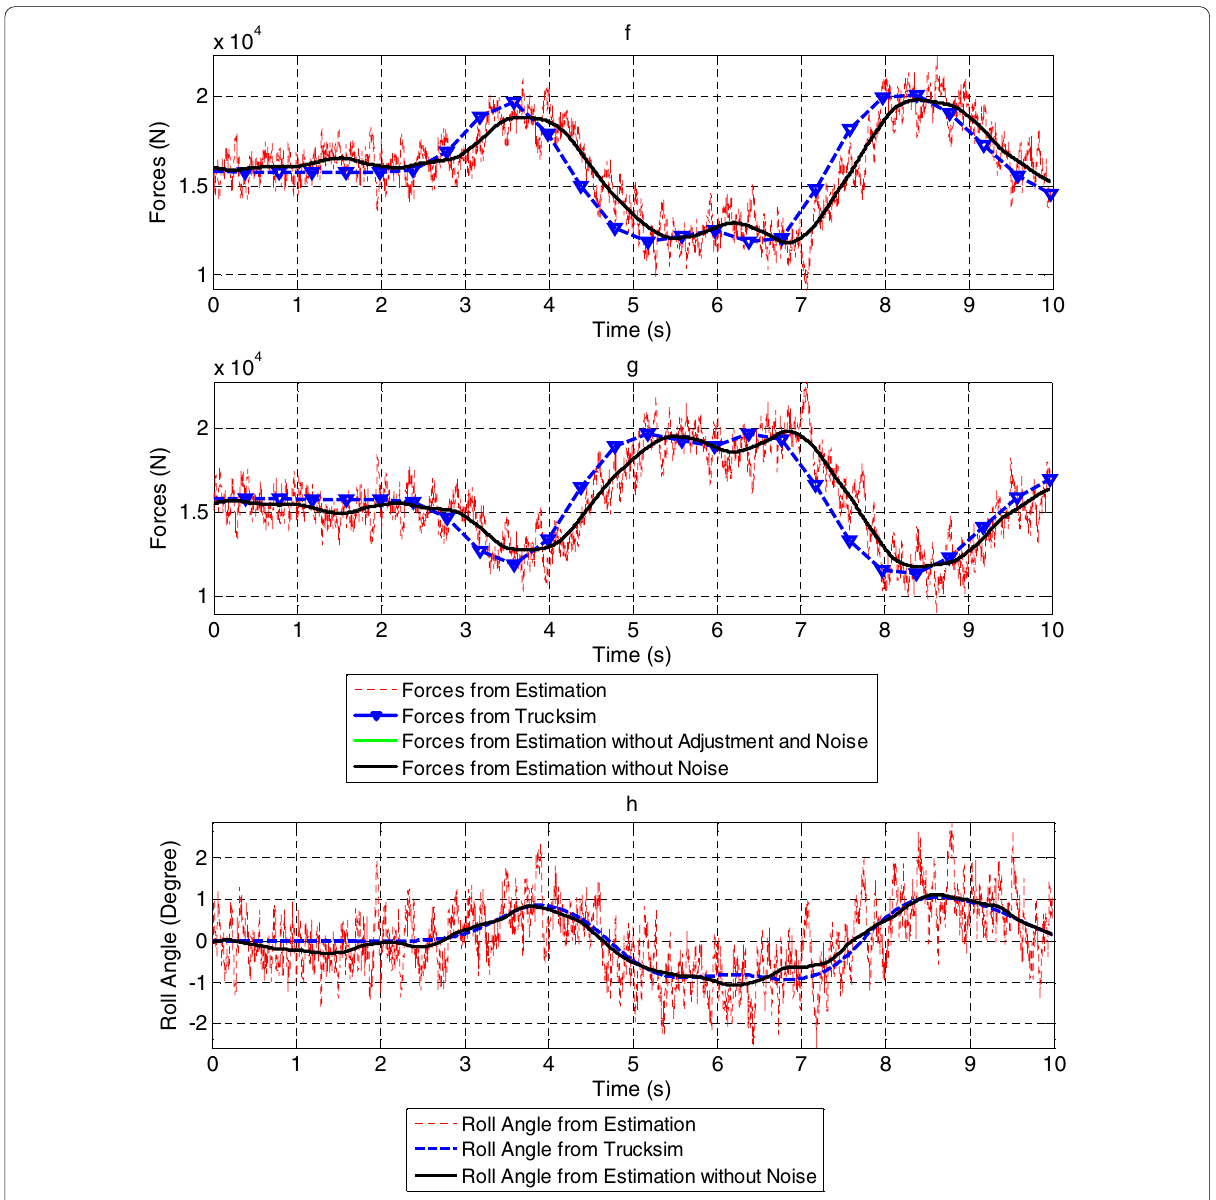
Roll Angle from Trucksim Roll Angle from Estimation without